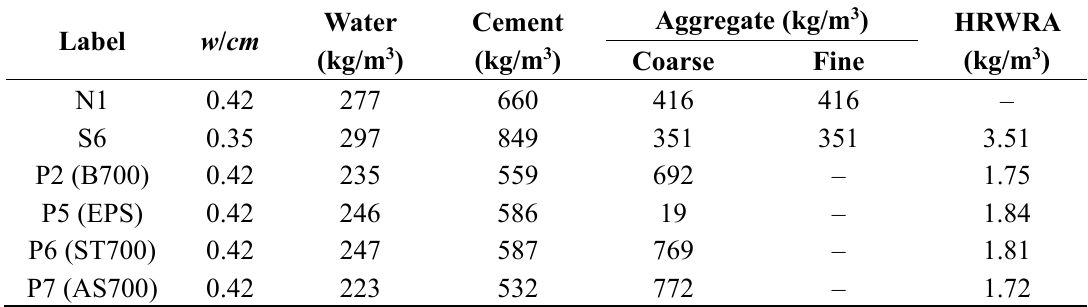
Table 3. Mix proportion for lightweight concrete. w / cm , water-to-cement ratio.